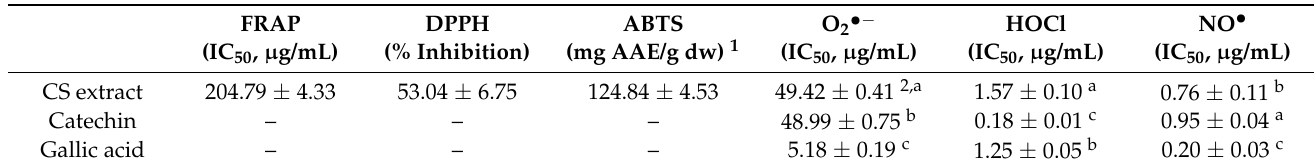
Table 1. Antioxidant/antiradical activity and radicals scavenging capacity of CS extract prepared by SFE. Values are presented as mean ± standard deviation ( n =